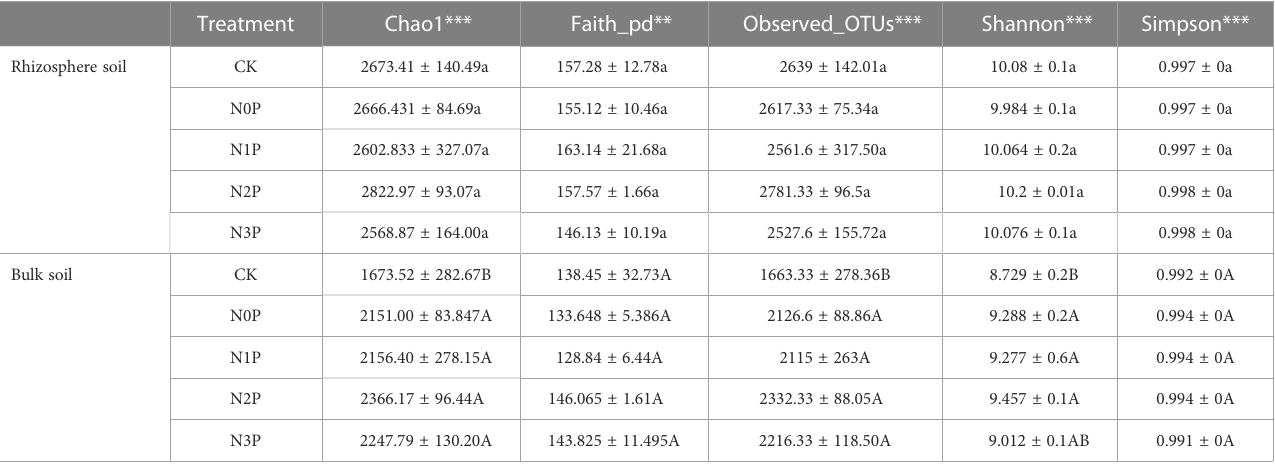
TABLE 2 The a -diversity of bacterial community in different N-P addition ratio